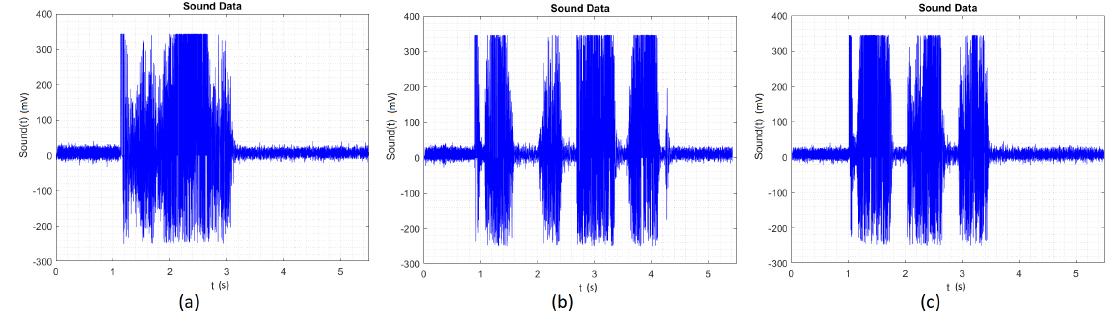
Figure 2. ( a ) Time signal for Circle. ( b ) Time signal for Square. ( c ) Time signal for Triangle.